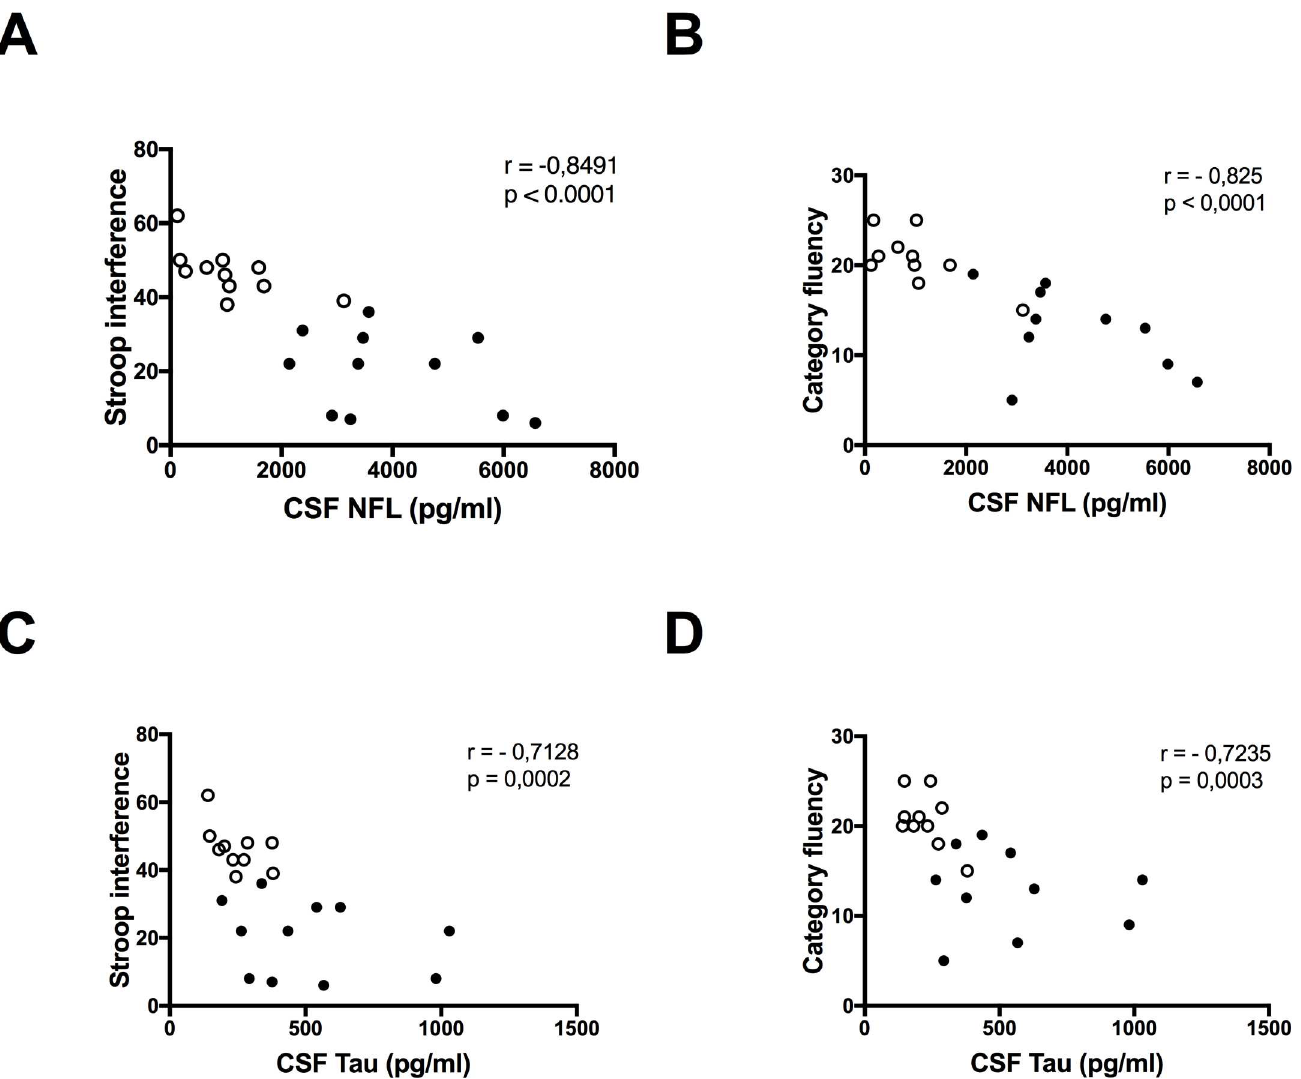
Fig 3. Comparing the correlations of neurofilament light and tau with cognitive test scores. Neurofilament light (NFL) has stronger correlations with clinical scores like ( A ) stroop interferens, and ( B ) category fluency, compared with ( C and D ) tau. ○ Premanifest geneexpansioncarrier • Manifest Huntington’s